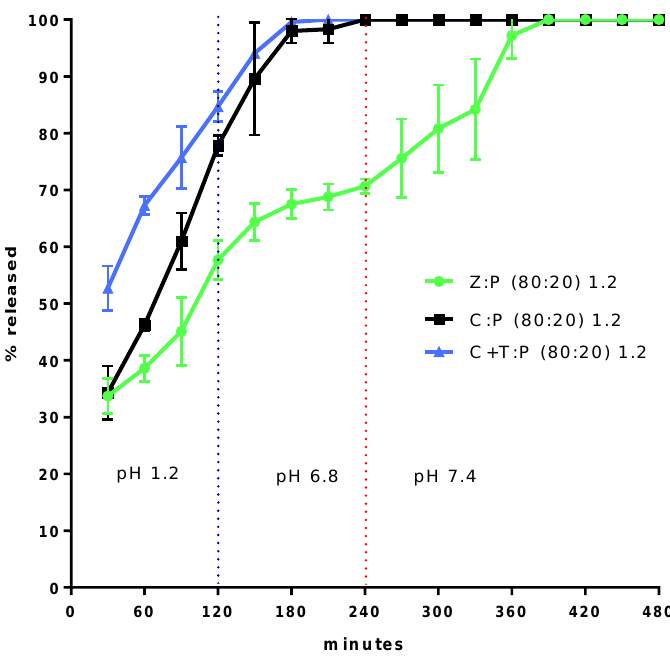
Figure 2. Ca 2 + fraction released from granules 1.2 mm size immersed, in sequence, in SGF, Figure 2. Ca 2+ fraction released from granules 1.2 mm size immersed, in sequence, in SGF, simulate